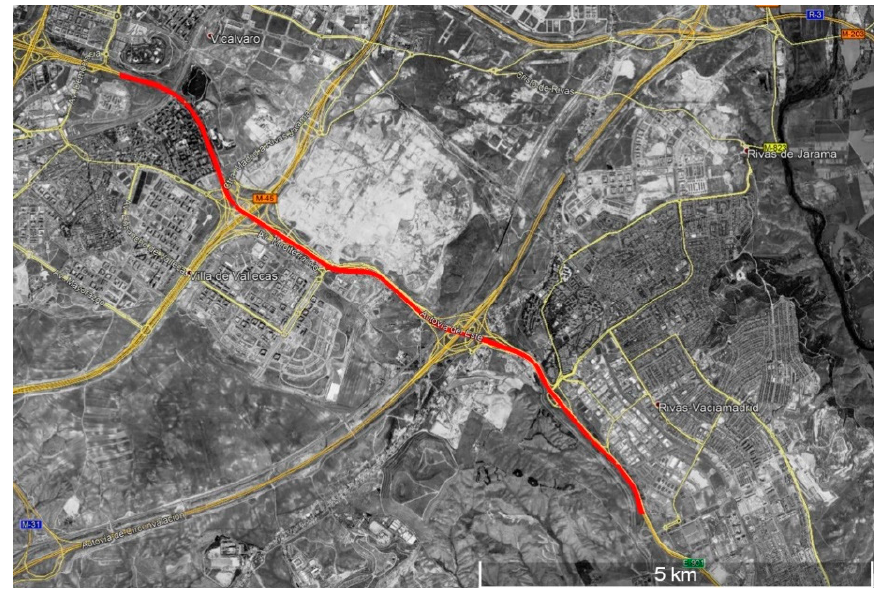
Figure 9. Highway test area.